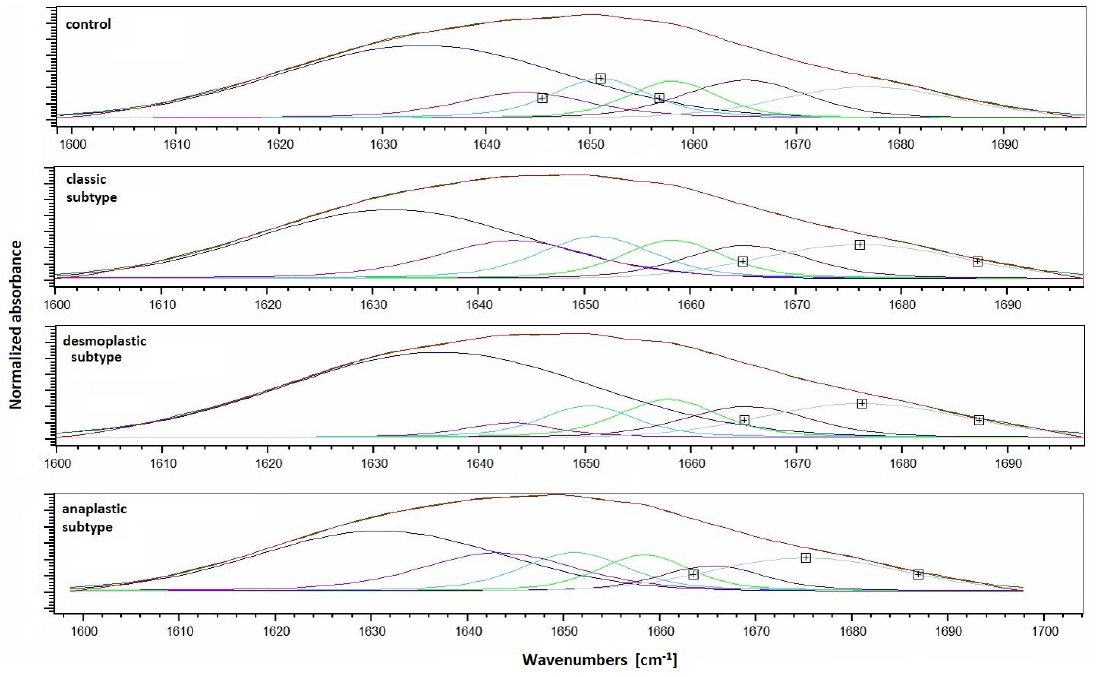
Figure 3. Curve-fitting of the amide I band of control and in various MB histological subtypes: classic, desmoplastic/nodular, and large cell/anaplastic.